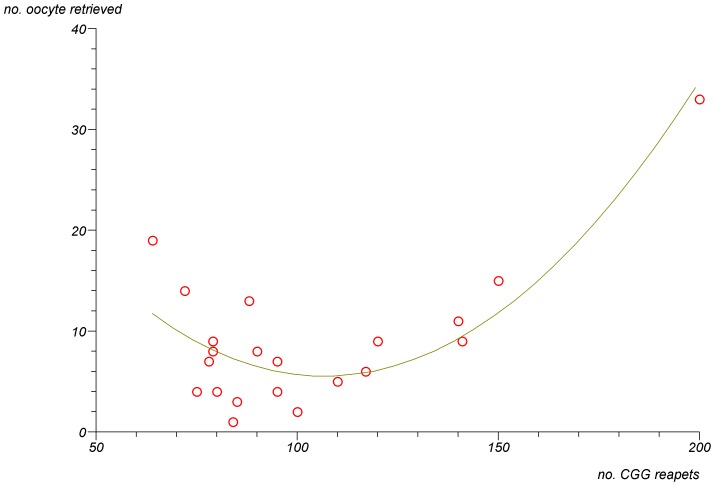
A non-linear association between the number of retrieved oocytes during IVF cycle and the number of CGG repeats in FMR1 premutation carriers (55–200 repeats).(P<0.0001).